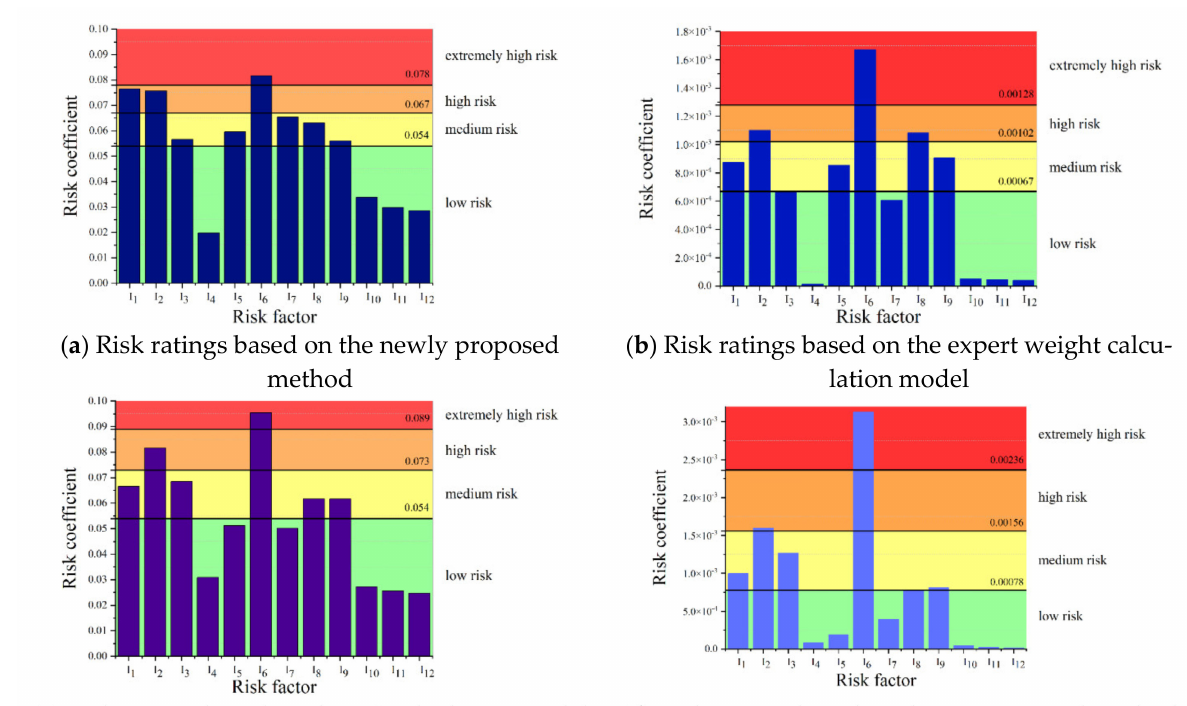
Figure 6. Risk ratings derived using various